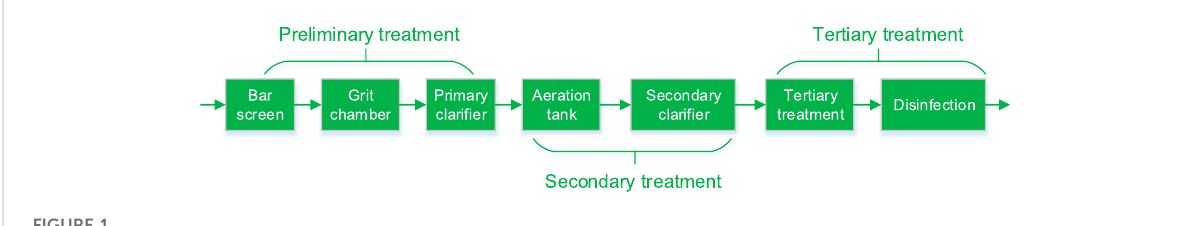
FIGURE 1 Schematic diagram of HWW treatment process including preliminary, secondary and tertiary treatment processes.